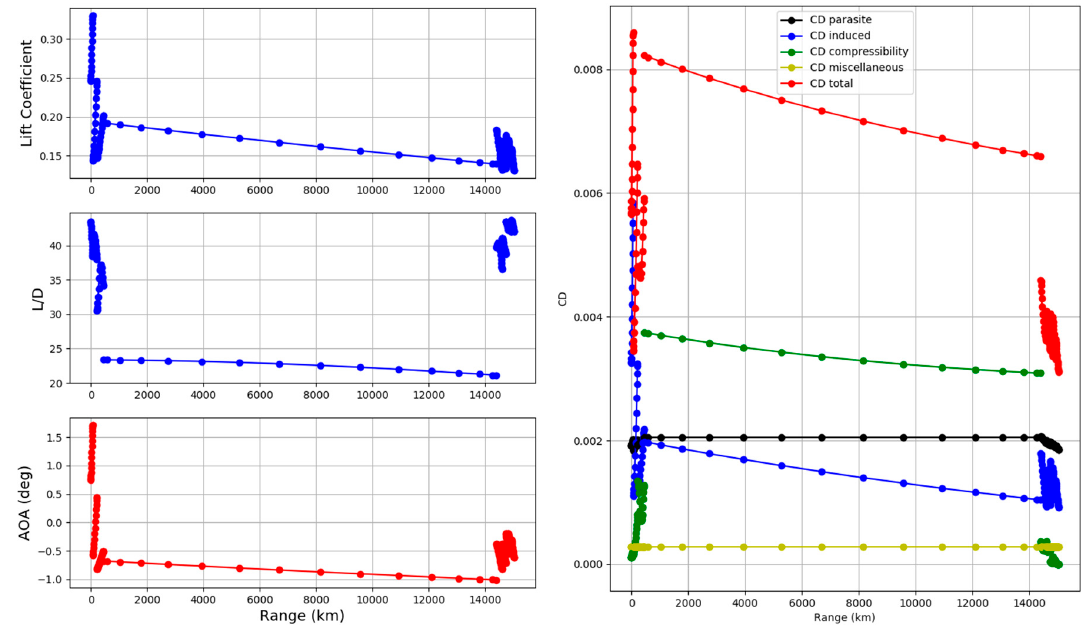
Figure A10. Aerodynamic performance of SE²A-LR.